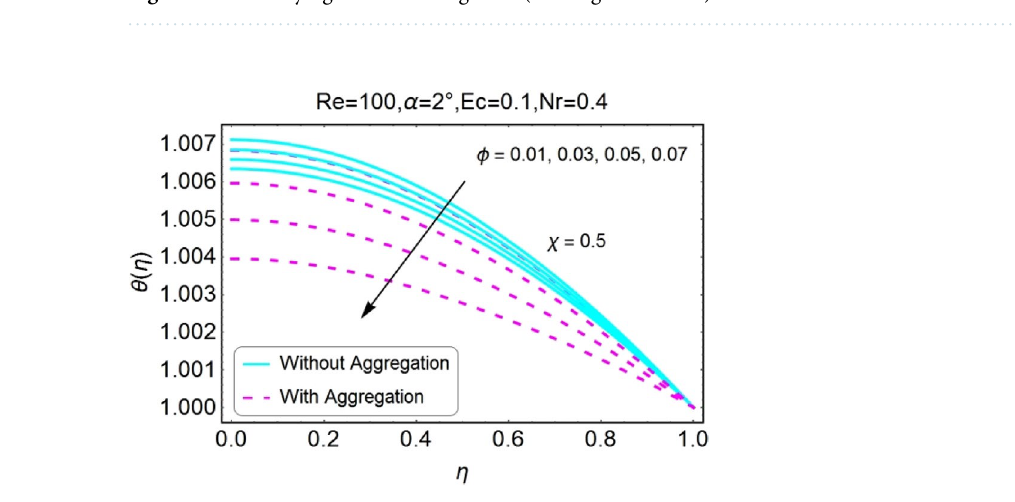
Figure 25. Nr varying θ for shrinking walls (convergent channel).